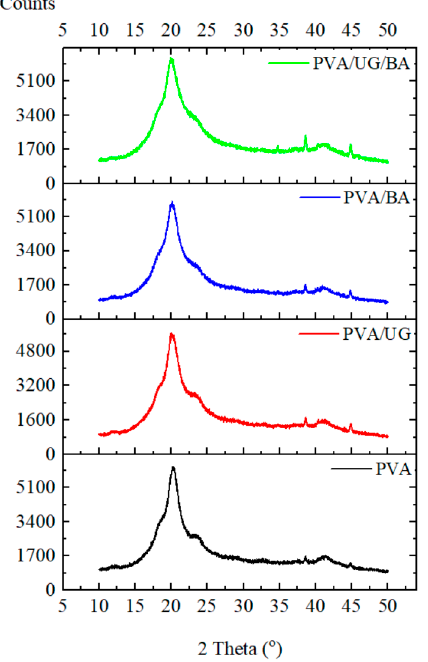
Figure 3. FTIR of PVA and the blend films.